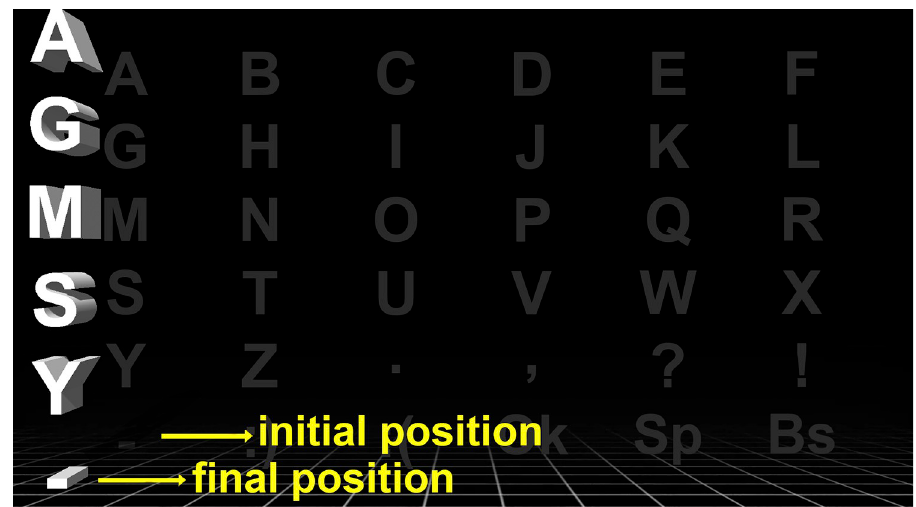
Fig 3. 3D-C paradigm screen shots on LED